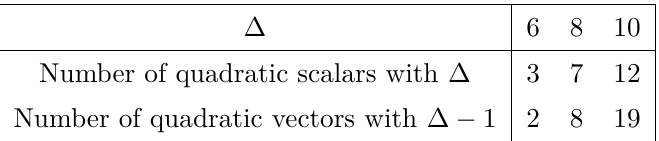
Table 1. The number of quadratic scalars and vectors in various